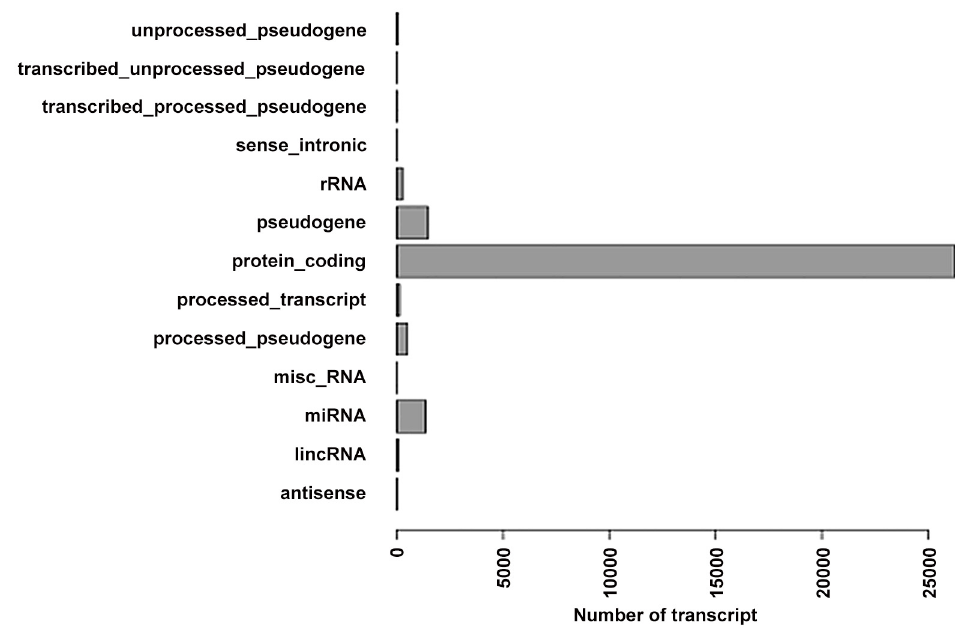
Fig 2. Analysis of LncRNA feature. (A) Summary of LncRNA type. (B)The exon number of LncRNA.